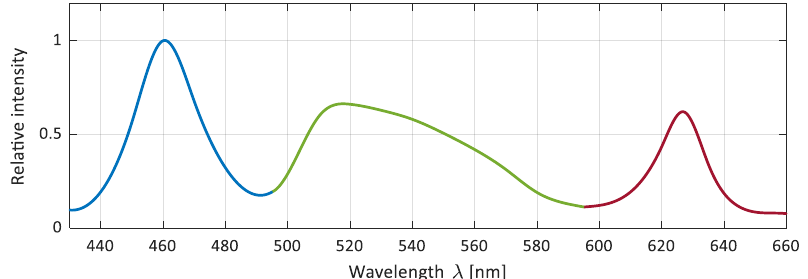
Figure 2. Spectral characteristics of MiniRay compact projector.